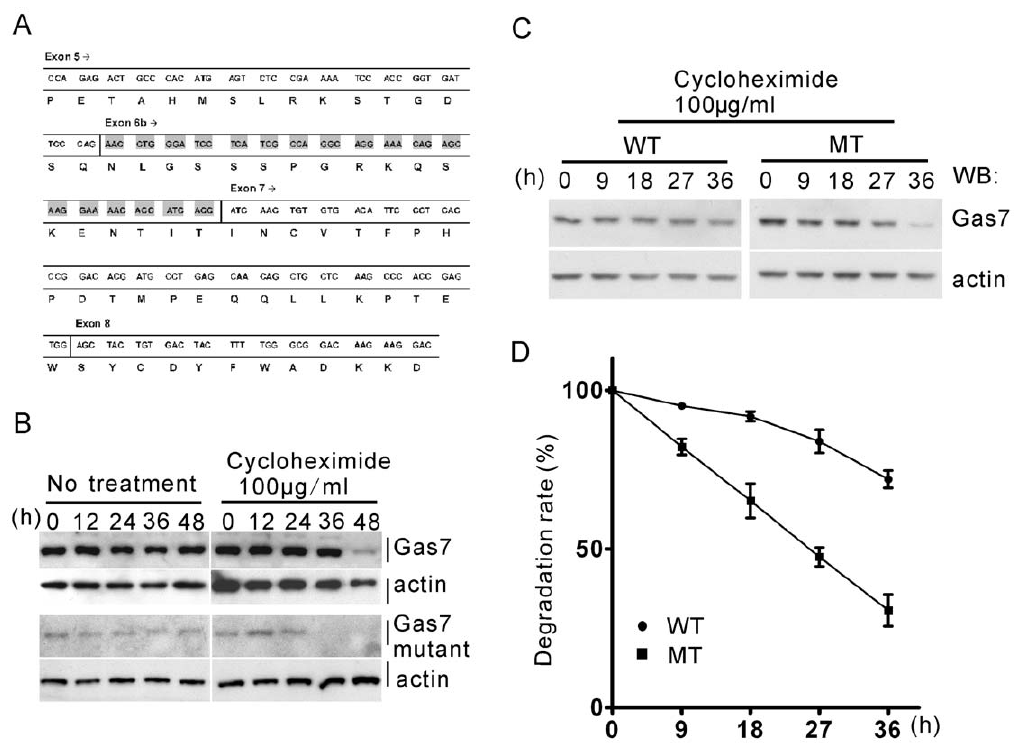
Figure 2. The truncated sequence of the Gas7 mutant is associated with control of Gas7 protein stability. (A) Total RNA from the cerebrum of Gas7-deficient mice was subjected to RT-PCR followed by direct cloning of gas7 cDNA. Sequence analysis showed that a total length of 54 nucleotides (comprising exon 6 b) was deleted from the Gas7 wild-type allele. (B) The endogenous Gas7 mutant protein degraded faster than wild-type Gas7 in primary culture of cortical neurons. A Primary culture of cortical neurons was isolated at E16.5 from Gas7 wild-type or deficient mice. At DIV7, protein stability was analyzed with or without 100 m g/ml cycloheximide at the indicated time points. (C) The ectopically expressed Gas7 mutant protein degraded faster than wild-type Gas7 in 293 T cells. Overexpression of Gas7 wild-type and mutant protein in transiently transfected 293 T cells was analyzed by Western blot. 293 T cells were transfected with 0.5 m g Gas7 wild-type (WT) or 2 m g mutant (MT) plasmids, followed by culturing in the presence of 100 m g/ml cycloheximide, and harvesting at 0, 9, 18, 27, and 36 h after treatment. (D) The degradation rate of the Gas7 mutant protein is about 50% while the wild-type is about 15% at 27 hours. The results reflect the mean of triplicate experiments.